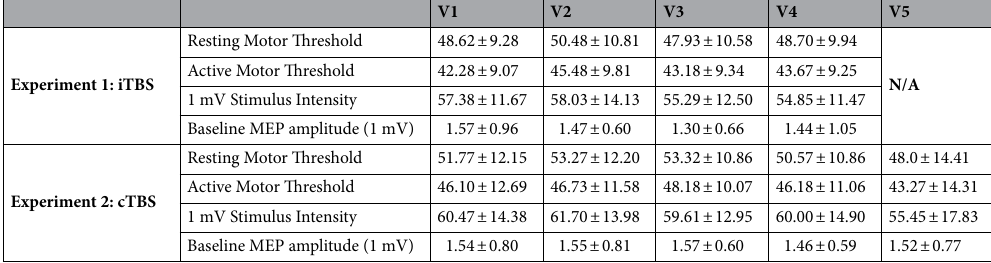
Table 1. Motor thresholds and baseline MEP amplitudes. Mean (± SD) resting motor threshold (%MSO), active motor threshold (%MSO), 1 mV stimulus intensity threshold (% MSO), and recorded baseline MEP amplitude